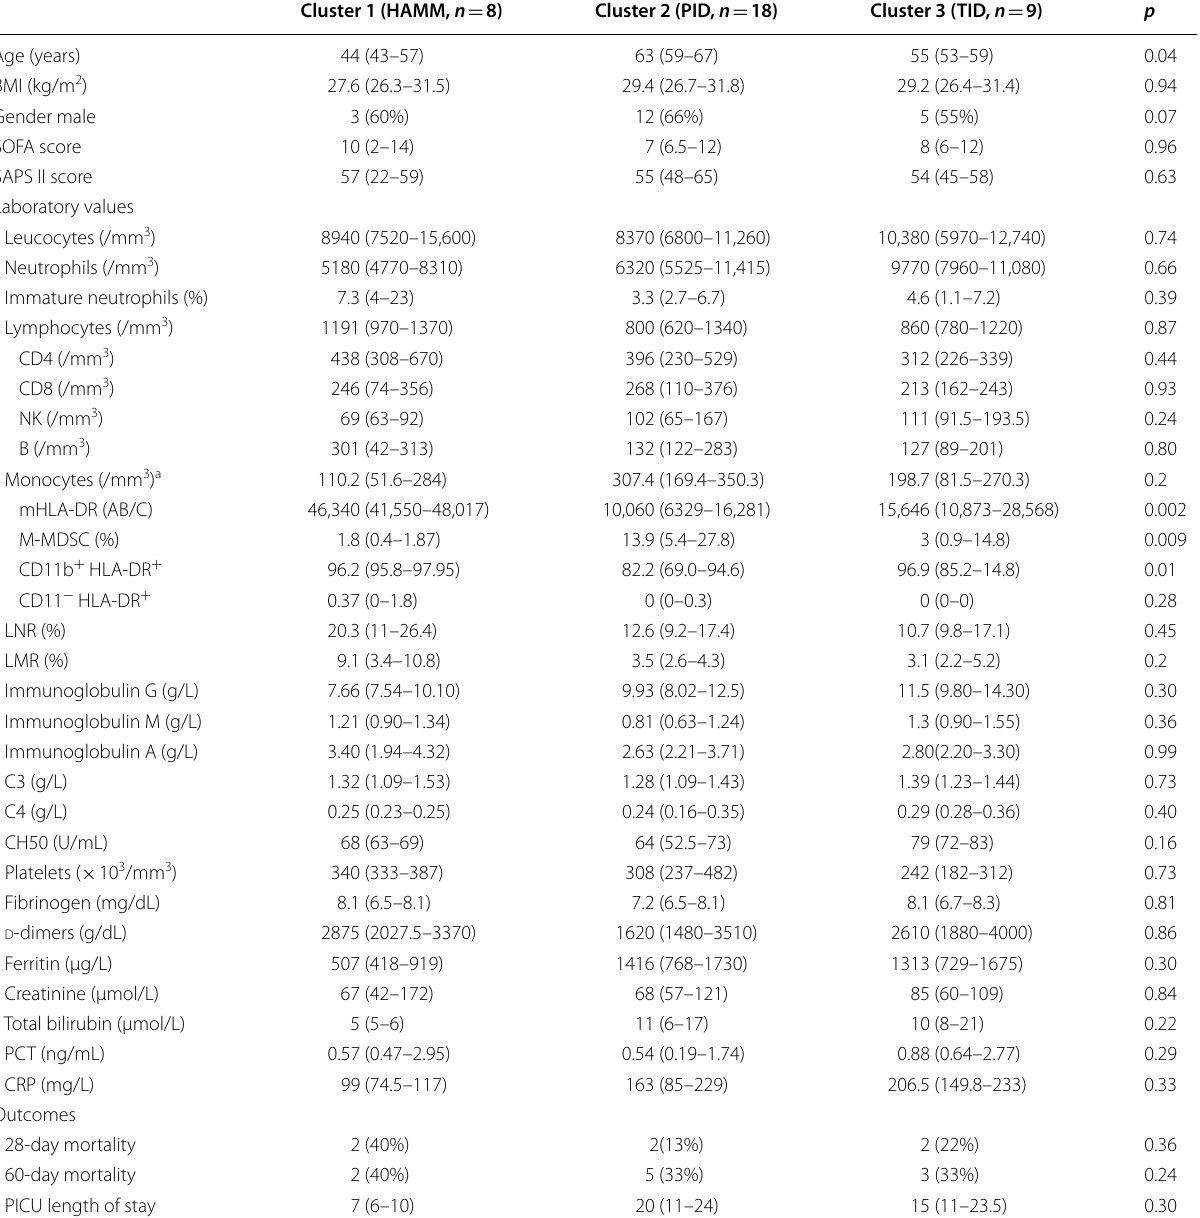
Table 2 Severe COVID‑19 myeloid phenotypes at